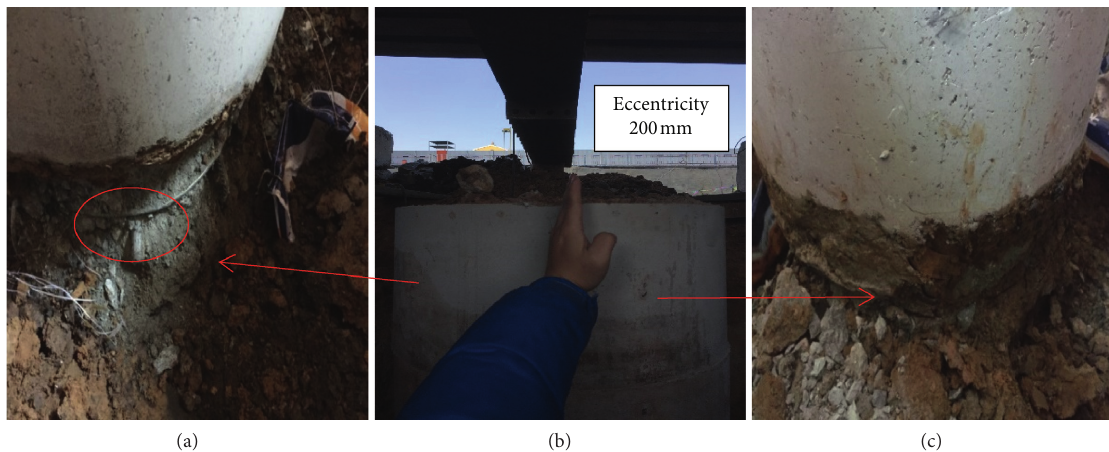
Figure 7: (a) Bent reinforcement of left part. (b) Eccentricity load. (c) Fractured concrete of right